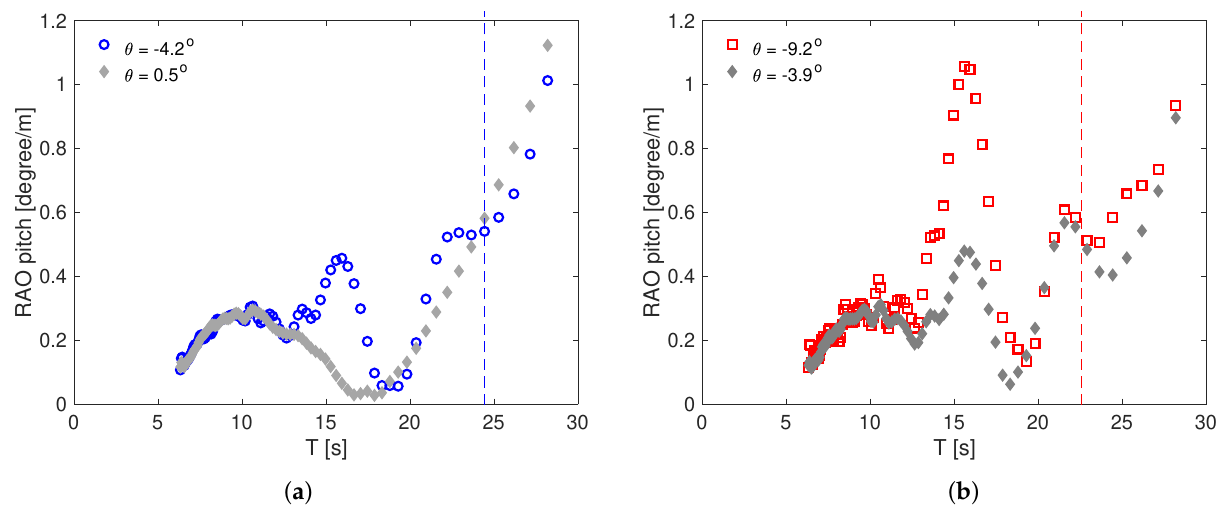
Figure 15. Concomitant effects of wind and waves on the RAO with and without TA: ( a ) v w = 7.8 m/s and ( b ) v w = 11.6 m/s. The dashed lines represent the experimental natural periods from Table 5.